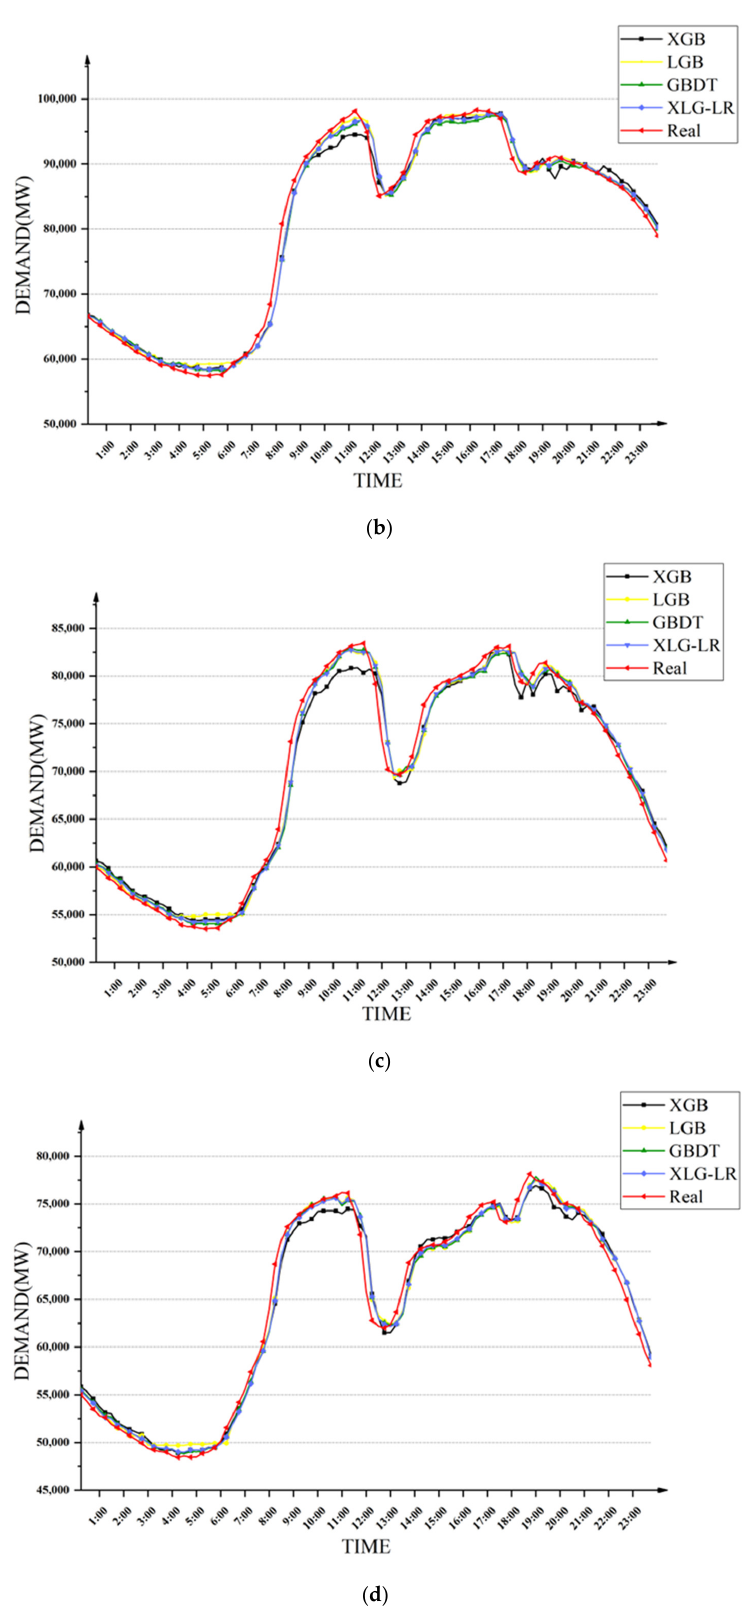
Figure 7. Four-season Power Demand Forecasting Results of Different Models. ( a ) spring; ( b ) summer; ( c ) autumn; ( d ) winter. Table 3. Evaluation Index for Four-season Power Demand Forecasting of Each Model.